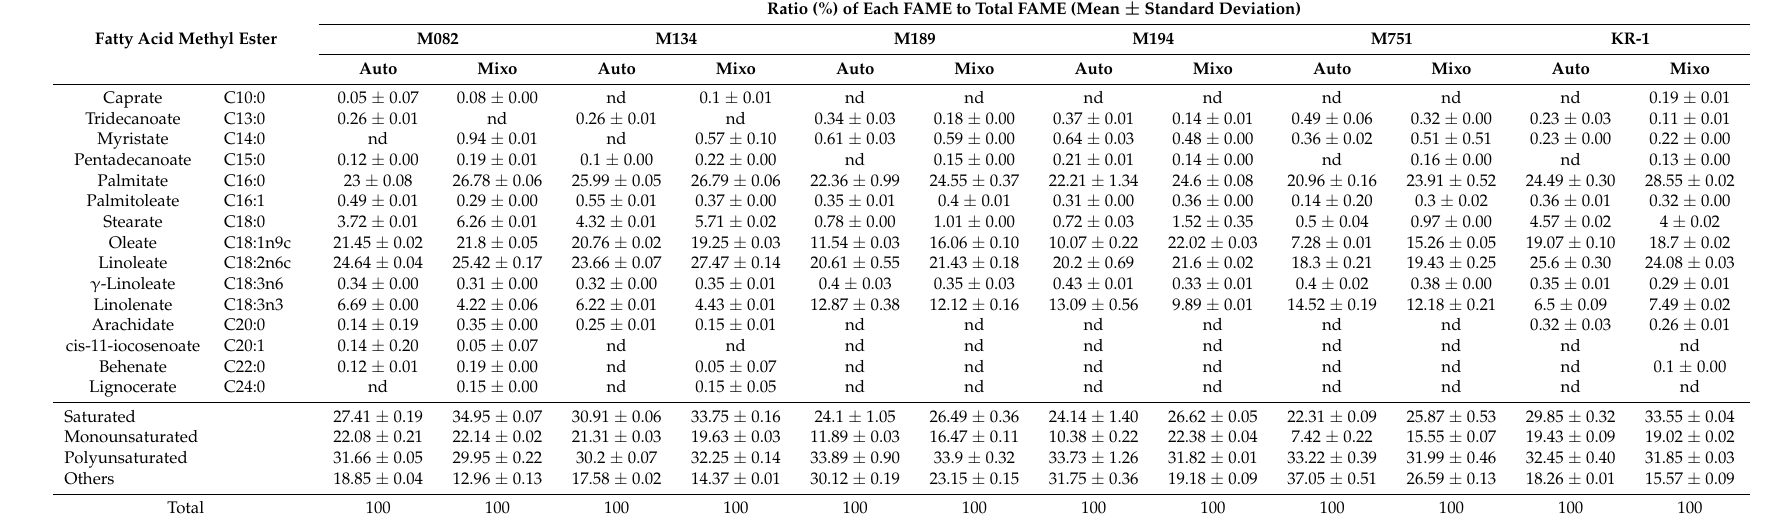
Table 1. FAME compositions of lipid extracted from six fast-growing Chlorella strains under autotrophic and mixotrophic conditions.